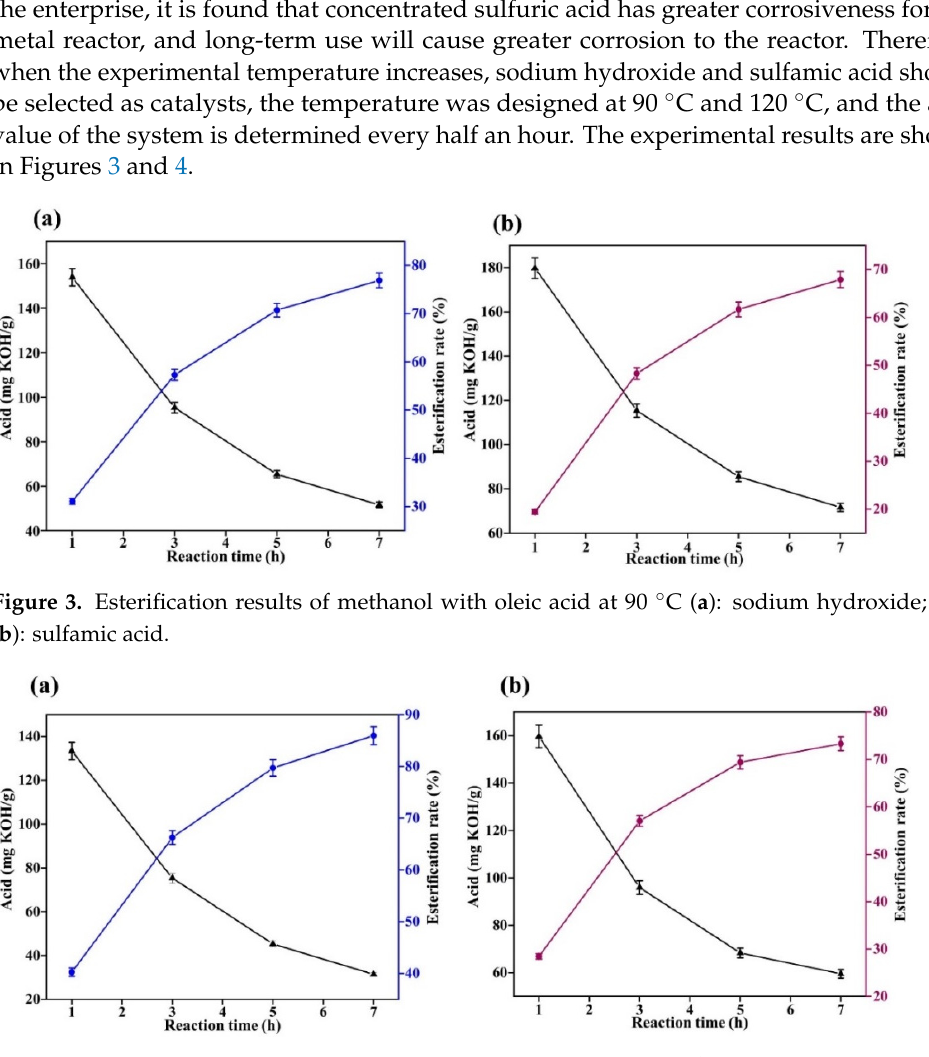
Figure 4. Esterification results of methanol with oleic acid at 120 ◦ C ( a ): sodium hydroxide; ( b ): sulfamic acid.